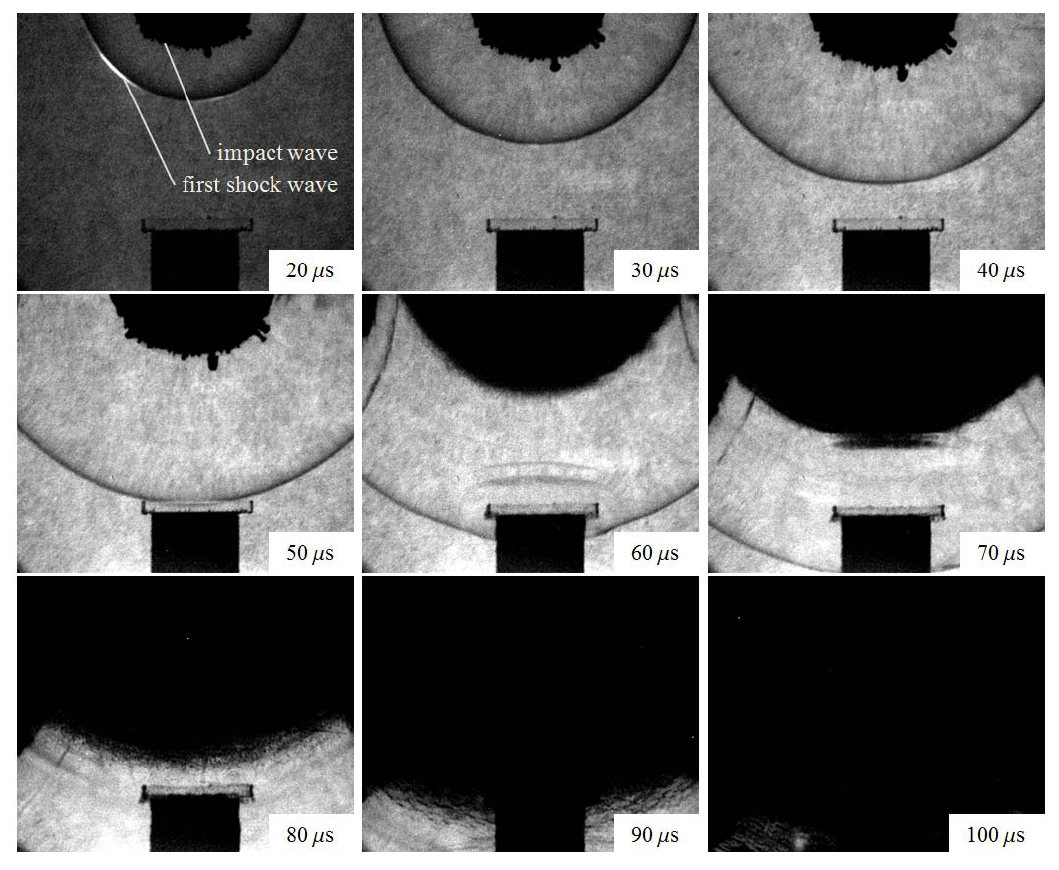
Figure 3. Shock wave propagation.